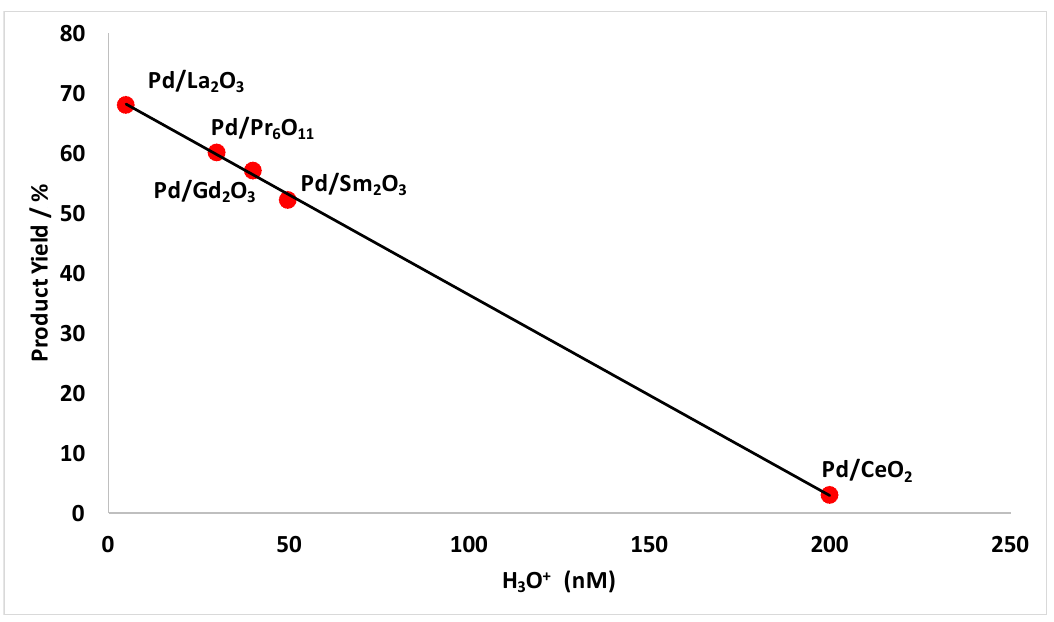
Figure 4. Cross ‐ coupling reaction yield (after 2 min of reaction) vs. proton molar concentration (10 − PZC ) for Pd/M x O y [10] (Adapted with permission from Springer Nature).